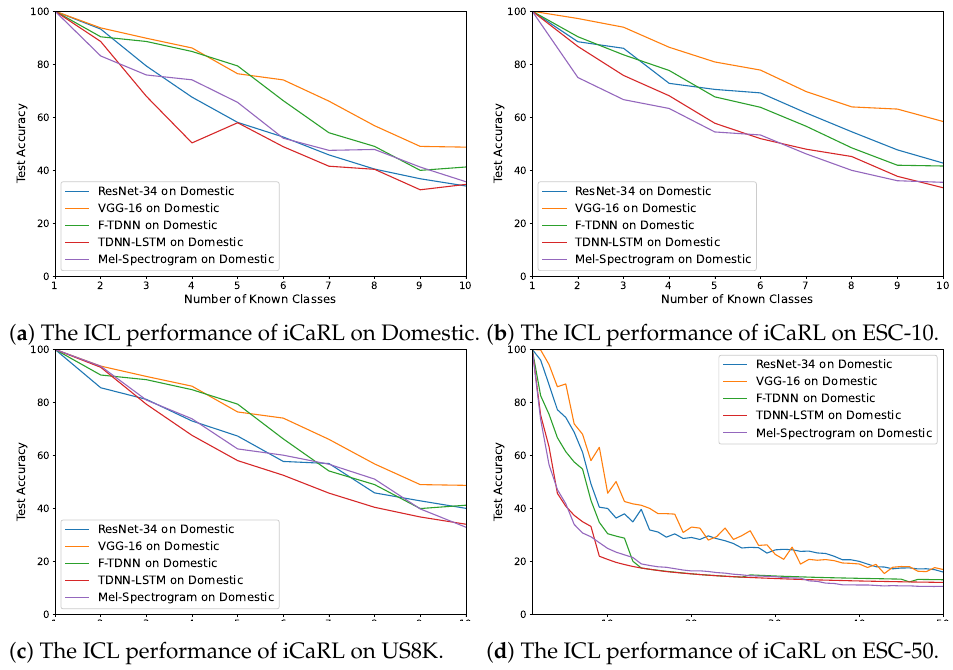
Figure 5. The average accuracy changes while incrementally learning new classes by iCaRL on the datasets: ( a ) Domestic, ( b ) ESC-10, ( c ) US8K, and ( d )